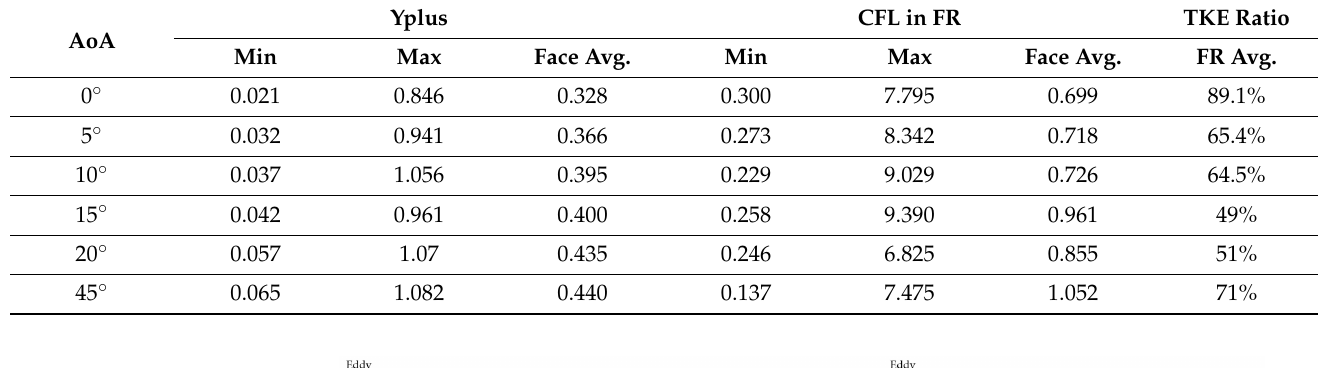
Table 1. Yplus, Courant–Friedrichs–Lewy number and turbulence kinetic energy ratio in Focus Region distribution.